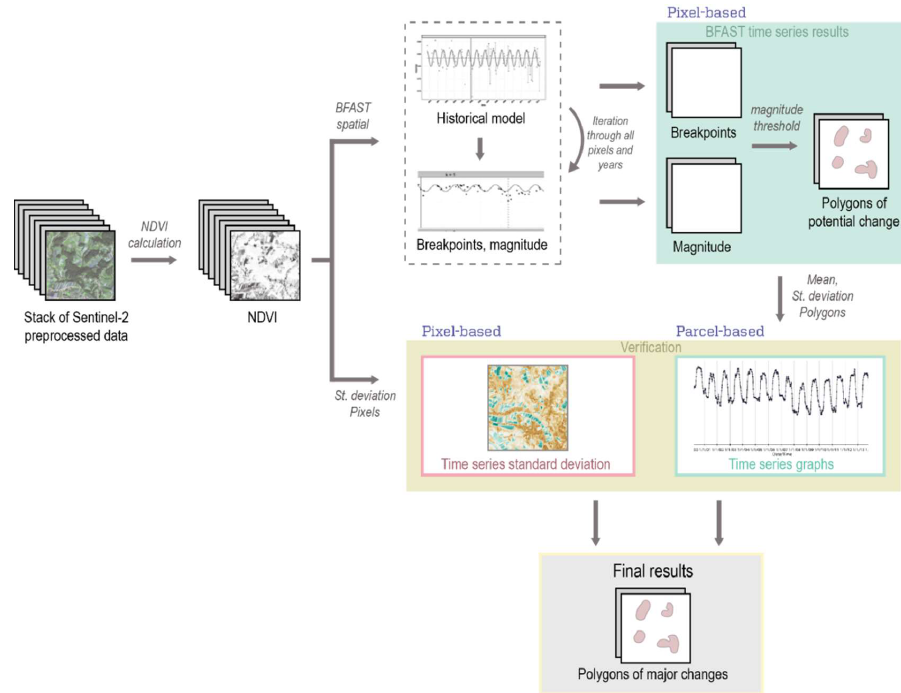
Figure 4. The general workflow of the pixel- and object-based time series approach adopted in this